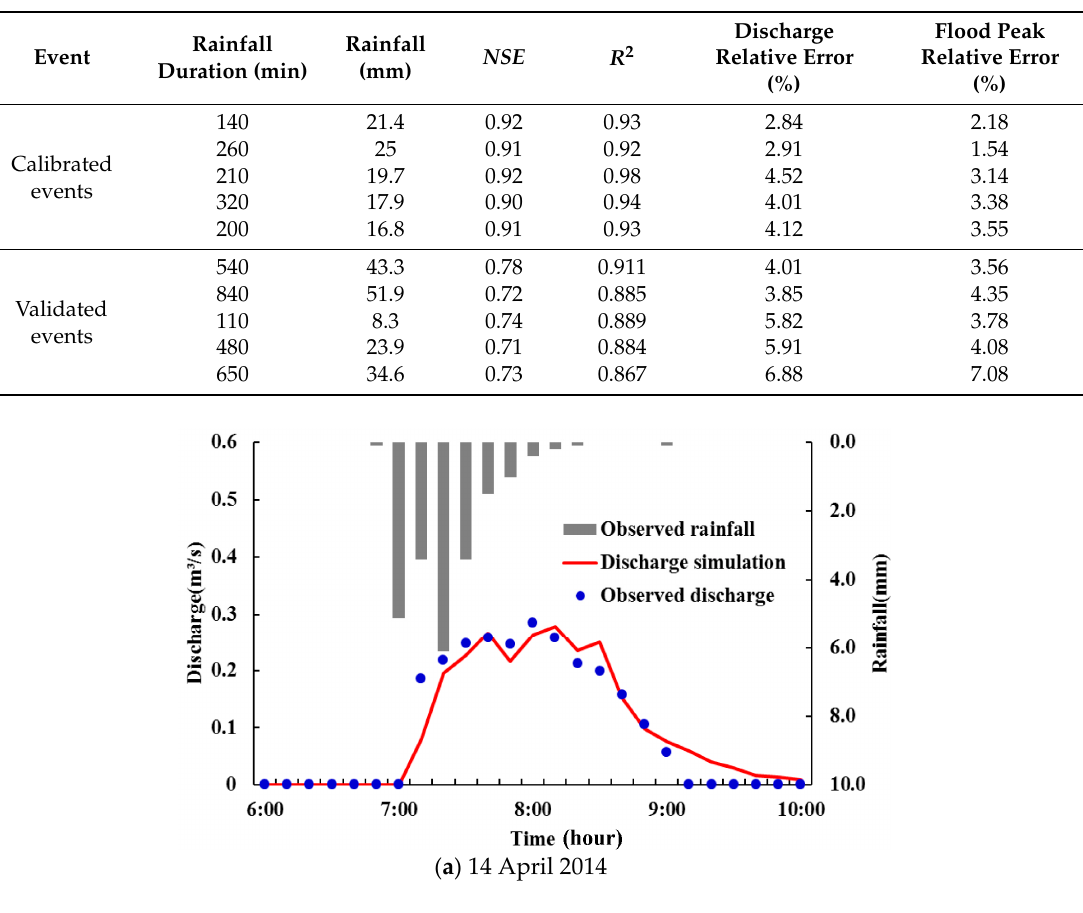
Table 4. Calibration and validation results of the rainfall–runoff model.